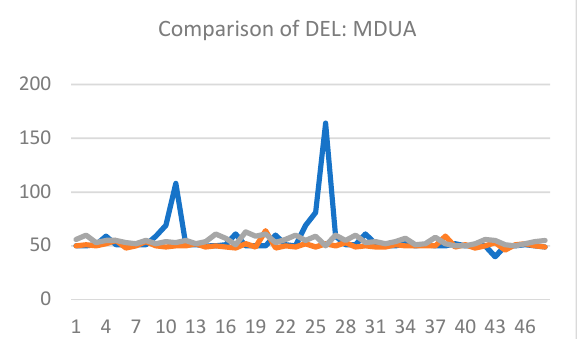
Figure A2. Comparison of UL speeds: MDUA.